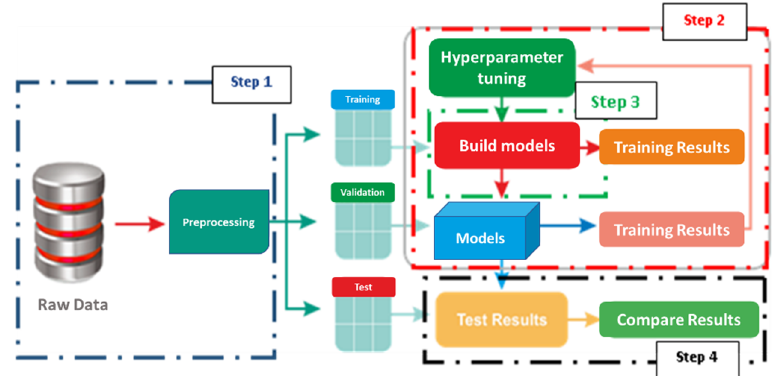
Figure 2. Block diagram of the proposed prediction of ECG signals.